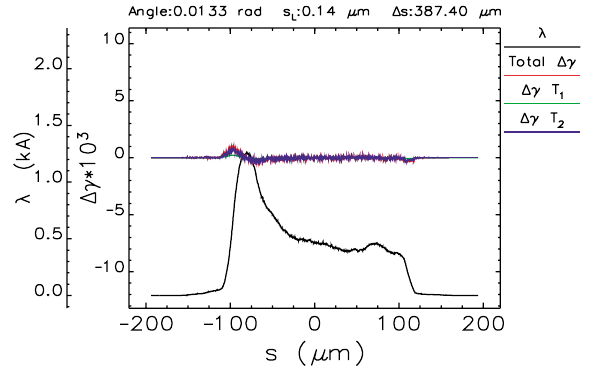
FIG. 6. (Color) Bunch distribution and CSR wakes near the beginning of the fourth dipole. In this and following figures, D s is the total length of the bunch.